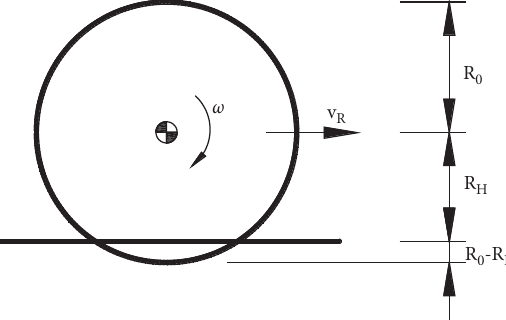
Figure 5: Schematic diagram of tyre loading